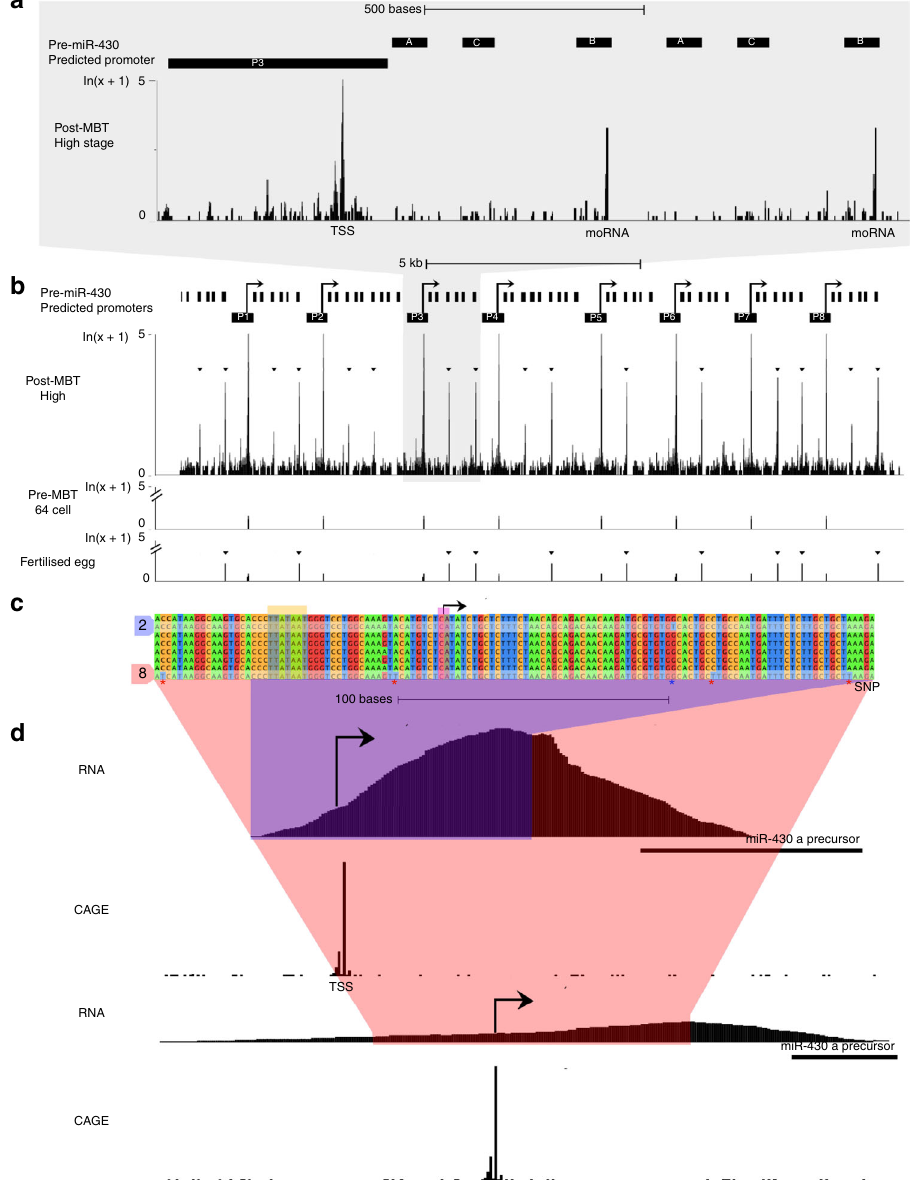
Fig. 2 Characterisation of the miR430 clustered locus demonstrates usage of multiple promoters. a , b Multi-site mapping of CAGE-seq provides evidence for activity of the miR430 cluster at early blastula stages. Schematic demonstrates transcription start sites (TSS) and internal RNA Drosha processing sites post (high stage) and pre-MBT (64-cell stage). The start position of microRNA offset RNA (moRNA) at the Drosha cutting site detected by CAGE is indicated. Black short bars indicate mature miRNA positions, long bar indicates predicted promoter region around the TSS. b At least 8 promoters are predicted by CAGE on the zebra fi sh reference genome (GRCz10). Candidate promoters are indicated by P1-P8, tag per million (TPM) signal is shown with a log scale. An additional cluster of miR430 genes without CAGE predicted promoter is shown on the left. c Promoter sequence alignment indicates SNPs among candidate promoters, which allow unique mapping of nascent RNA sequencing data for mapping of promoter usage. Orange box indicates predicted TATA box at the canonical position from the main TSS mapped by CAGE-seq. P3 and P9 carry unique bases for unique detection of transcripts driven by these promoters. d nascent RNA-seq data uniquely mapped to the miR430 locus demonstrates start site region utilization by at least two promoters indicated by CAGE-seq. RNA sequencing peaks drop at precursor gene start due to lack of SNP in the highly repetitive miRNA precursor